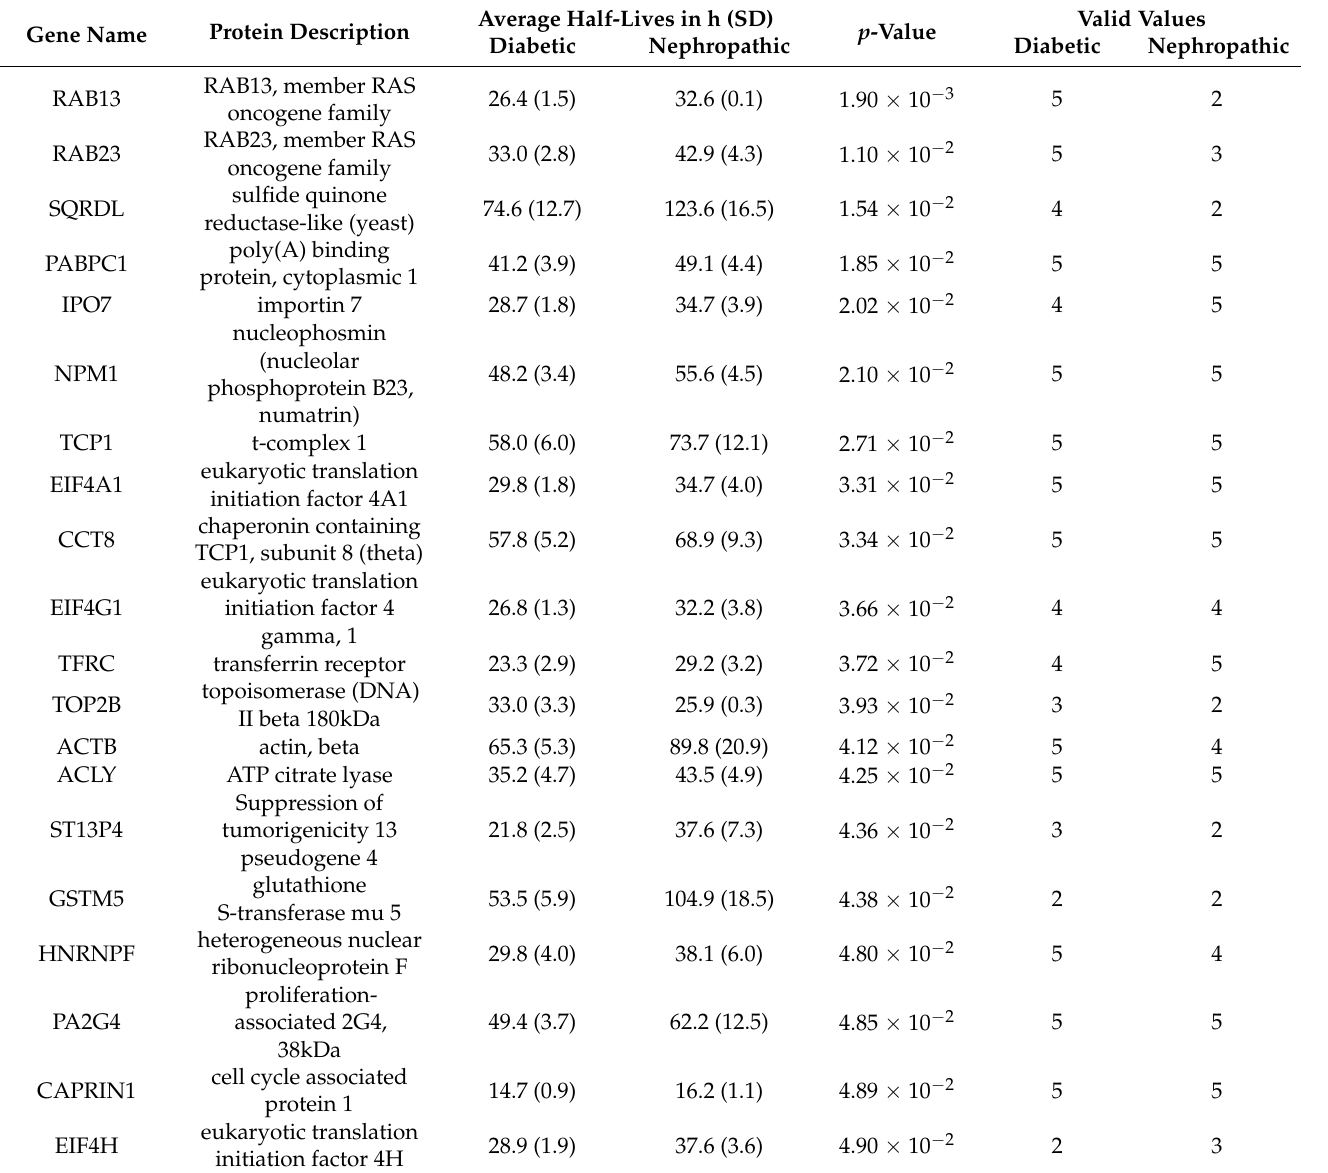
Table 2. Proteins with a significantly different half-life in Diabetic and Nephropathic